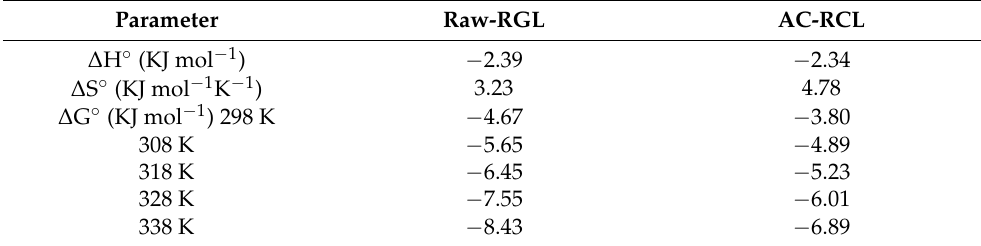
Table 6. Thermodynamic studies of Raw-RGL and AC-RGL and their parameters.